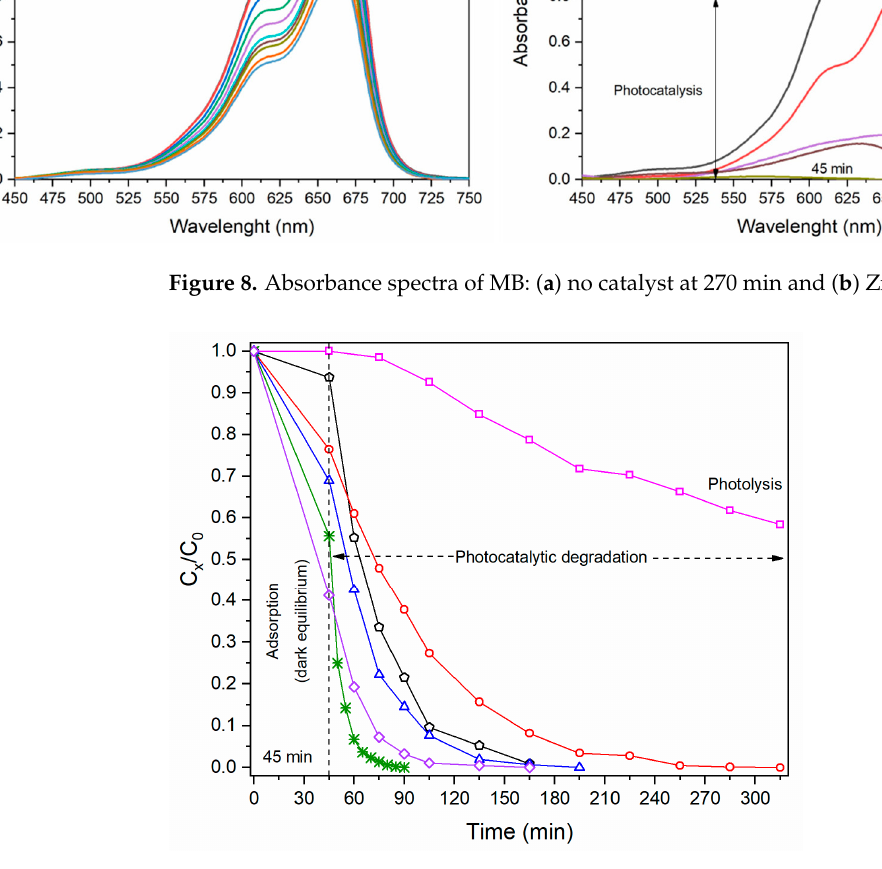
Figure 9. C x / C 0 plots of MB with ( ⎯ ) No catalyst, ( ⎯ ) No extract, ( ⎯ ) Azadirachta indica , ( ⎯ ) Chry- santhemum morifolium , ( ⎯ ) Lentinula edodes , and ( ⎯ ) Tagetes erecta. The first 45 min correspond to MB adsorption during dark equilibrium.